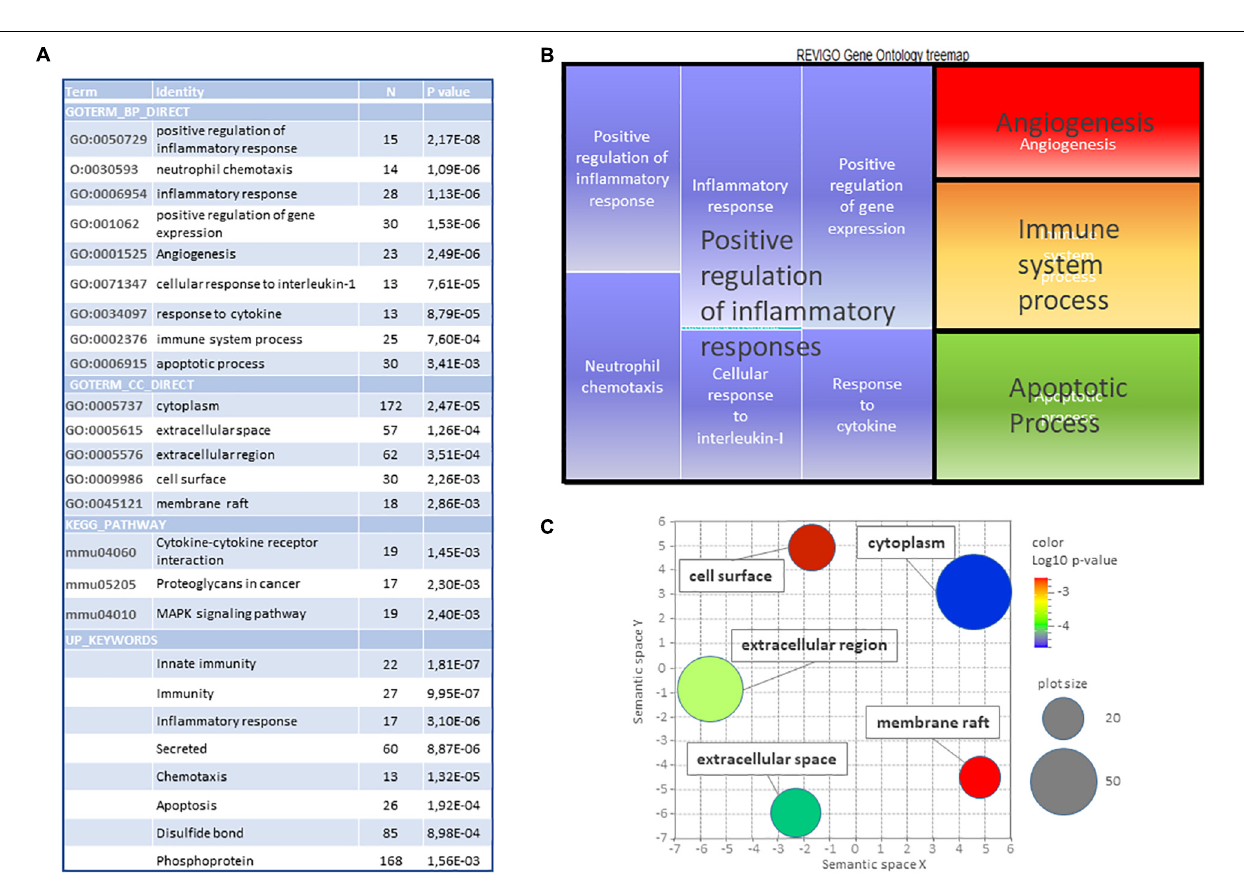
FIGURE 4 | Gene ontology study of the common core of 386 genes affected by HI in P5 and P10 brains. (A) DAVID (v6.8) identification of significantly enriched GO-terms (dispensability < 0.7), Kegg Pathways and Keywords ( N ≥ 10, p < 0.01). (B) Treemap representation of biological processes GO terms (BP). (C) Scatterplot representation of cell components (CC) GO terms. Color scale indicates p -values. Circle diameters represent the number of genes